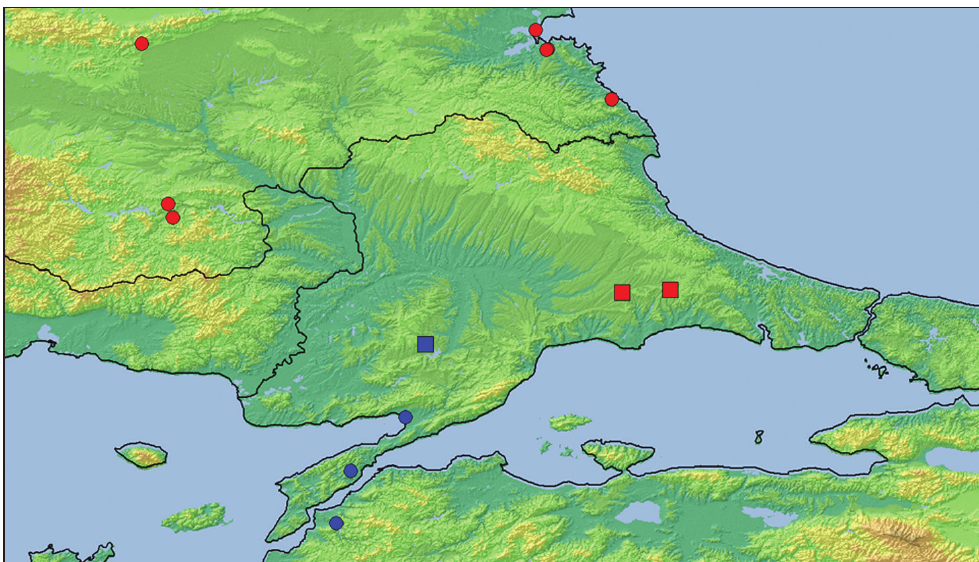
Figure 5. Distribution map of Rhagades amasina (blue) and Rh. pruni (red) in the Thrace Region. New data are marked as